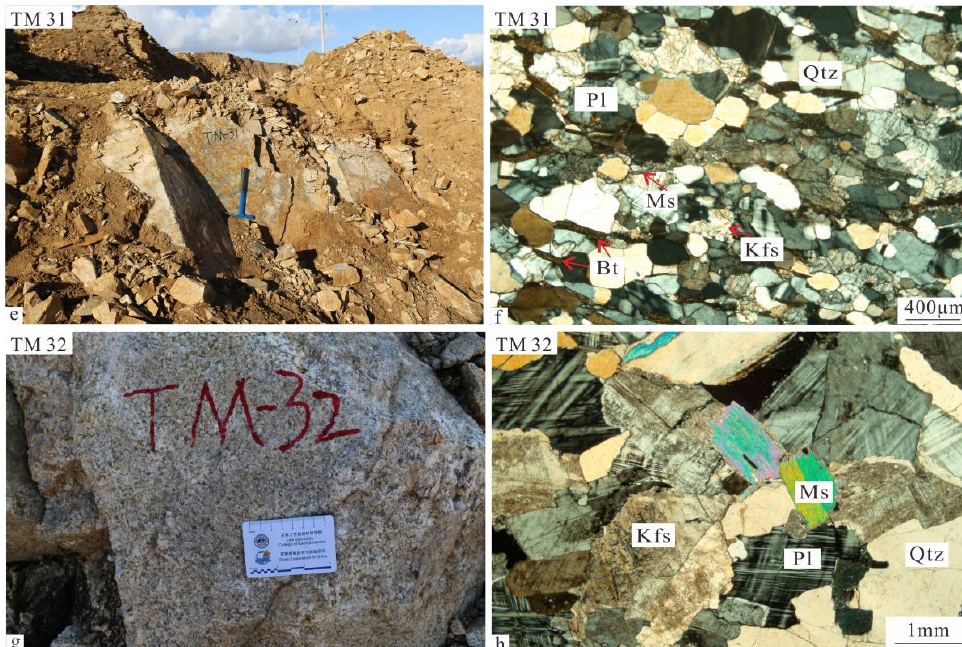
Figure 3. Representative outcrops and photomicrograph of garnet muscovite schist (from Jianshan